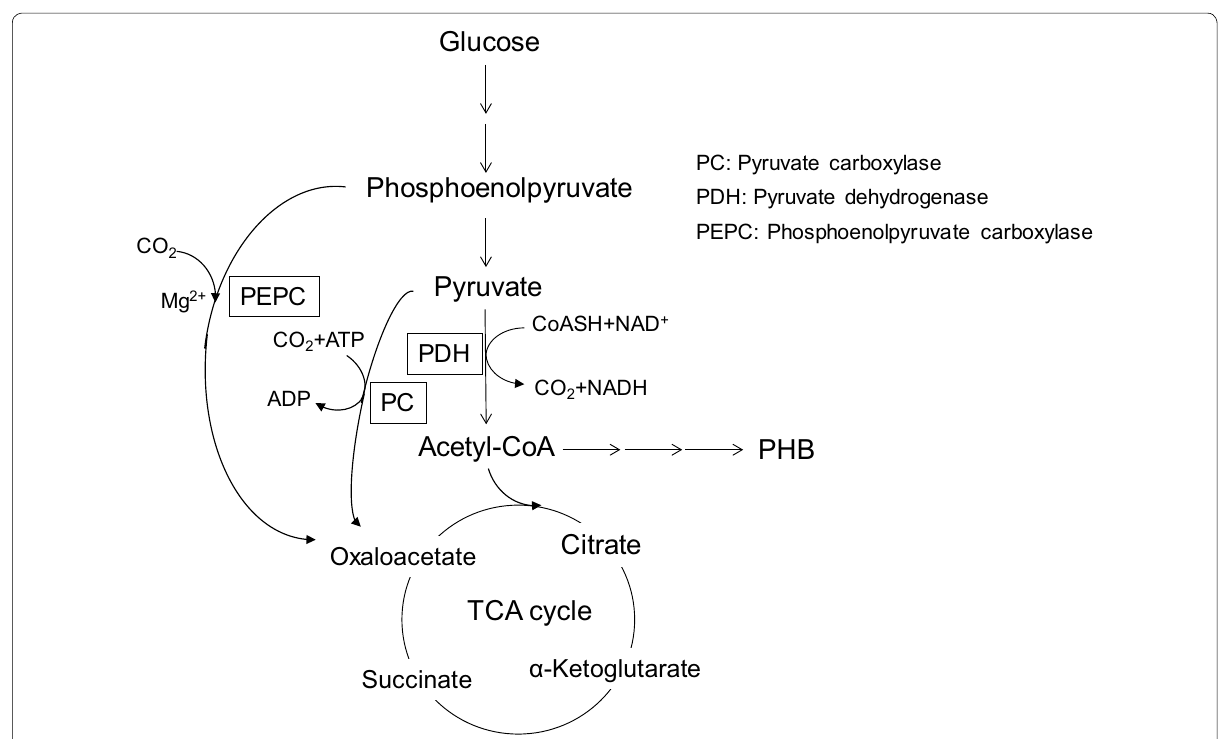
Fig. 4 Metabolic pathway of butanoate metabolism in Halomonas sp.